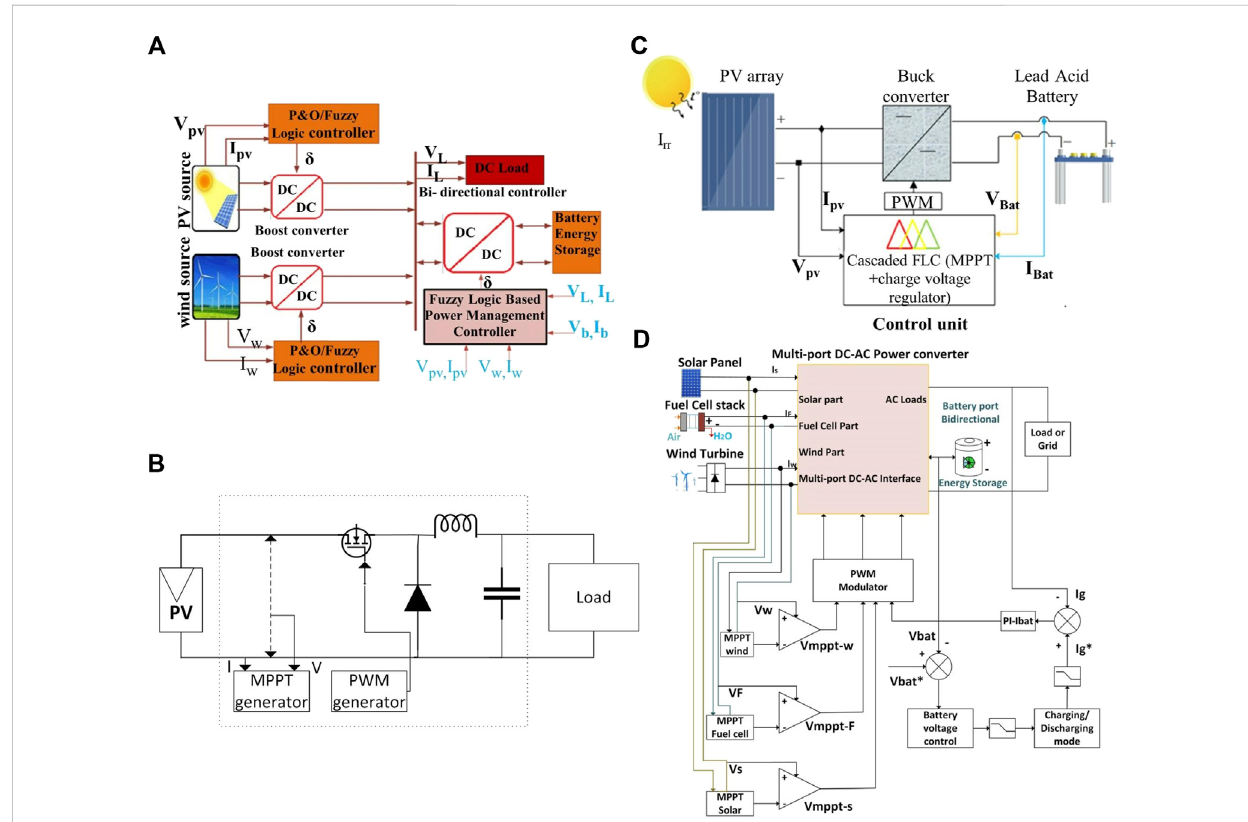
FIGURE 10 PV-Batterychargecontrollertopologyusing (A) Fuzzy-basedbatteryenergymanagementinahybridsolarandwindrenewablesystem(Nagaiahand